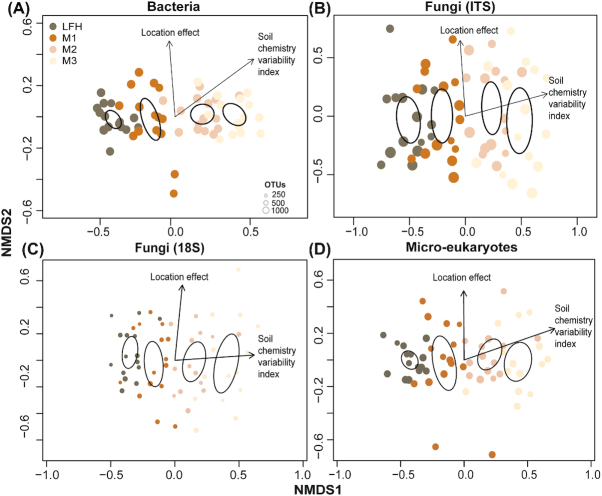
Nonmetric multidimensional scaling (NMDS) plots displaying the community structure of the different microbial groups. Bacterial (A), fungal (ITS: B; 18S: C) and micro-eukaryotic (D) community compositional patterns among samples from different soil depth (forest floor (LFH) and three mineral soil layers: 0–5 cm (M1), 5–15 cm (M2), and 15–30 cm (M3)), as revealed by NMDS ordination analysis. The ordination plots are based on all Operational Taxonomic Units (OTUs) present in the respective microbial groups. The stress value for NMDS ordination was 0.104 for bacteria, 0.166 for fungi (ITS), 0.193 for fungi (18S) and 0.135 for micro-eukaryotes. Ellipses indicate 95% confidence intervals around centroids for each soil depth. Arrows point in the direction of maximum increase of the variables and size of circle indicates number of OTUs richness. All variables and factor shown in the panels had significant effects (P < 0.05) on the ordination configuration.